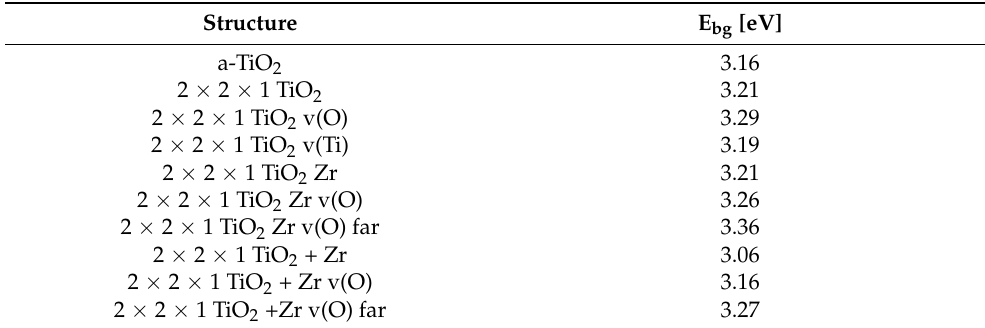
Table 3. The energy of the bandgap calculated by using the DFT/PBE+U method for all modeled structures (the same description as in Table